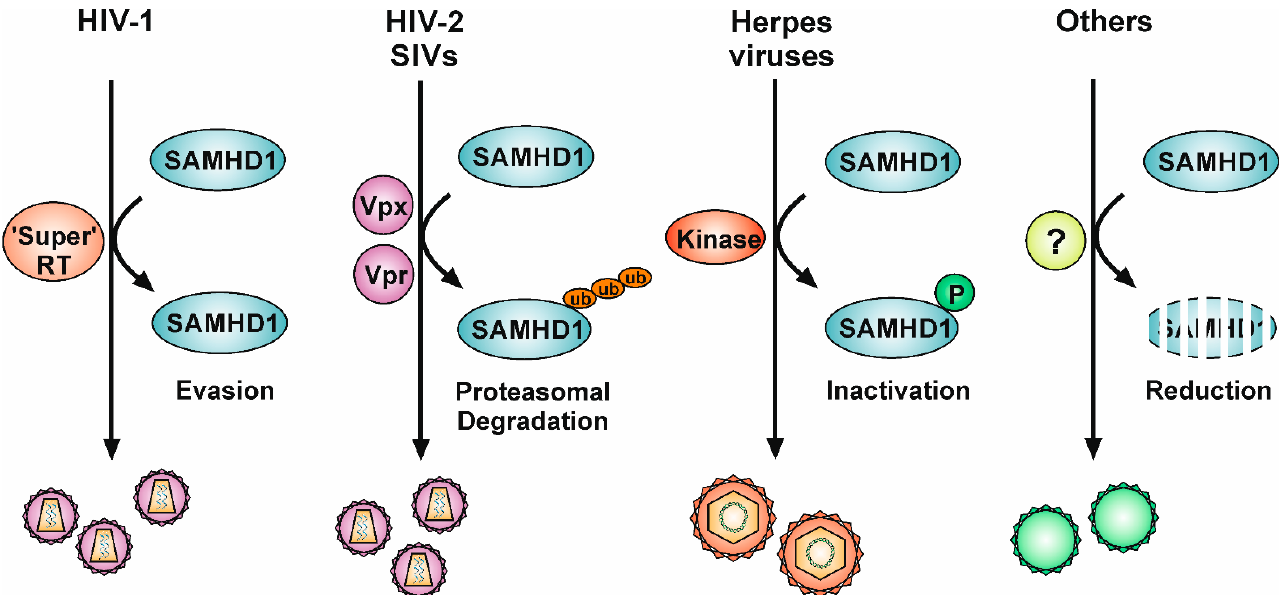
Figure 2. Viral countermeasures to circumvent the intrinsic restriction factor SAMHD1. Retroviruses without a Vpx-like function, such as HIV-1, encode a highly efficient reverse transcriptase (“Super” RT) that enables the virus to reverse- transcribe its genome despite the presence of active SAMHD1 and the resulting low dNTP level. HIV-2 and related SIVs encode the small accessory protein Vpx (or Vpr with a Vpx-like function), which ties SAMHD1 to a Cullin E3 ubiquitin ligase complex, resulting in ubiquitination and subsequent proteasomal degradation of SAMHD1. Herpesviruses, especially β - and γ -herpesviruses, rely on their conserved serine/threonine protein kinases to phosphorylate and thereby inactivate SAMHD1. In addition, HCMV infection also induces the proteasomal degradation of SAMHD1. Infection with other viruses, such as HSV-2, HBV, and HPV16, has been reported to cause a reduction in SAMHD1 RNA or protein levels, suggesting that additional unknown mechanisms exist to circumvent the SAMHD1-mediated restriction. Ub: ubiquitination, P: phosphorylation.